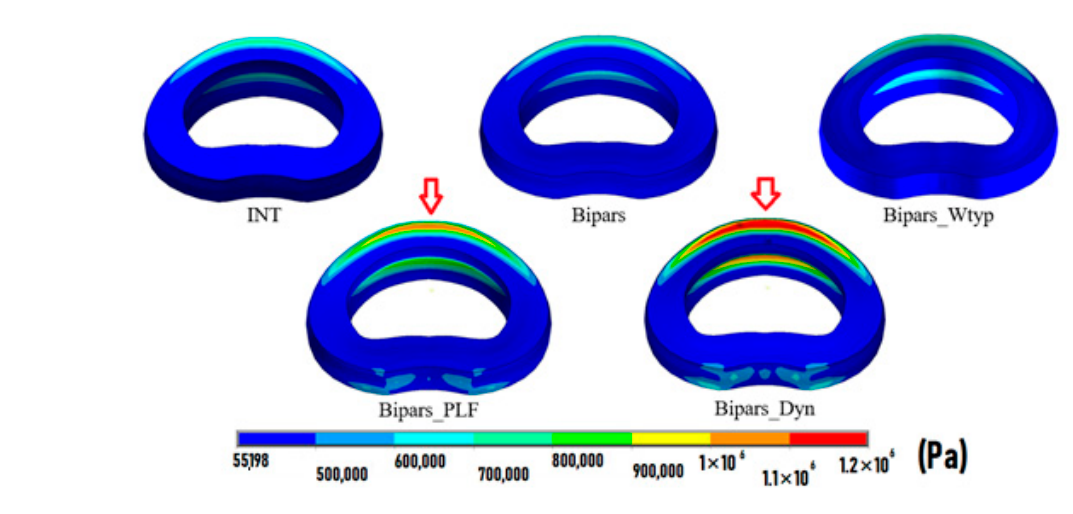
Figure 5. Adjacent disc stress (L3–L4) in flexion. Note: Red arrows indicate points of high stress.